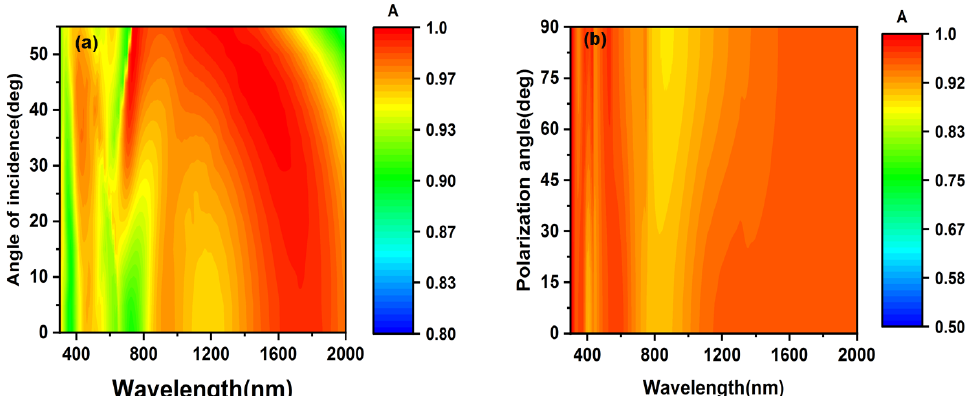
Figure 11. ( a ) The evolution of absorbers’ absorption as the incident angles increases from 0° to 55°. ( b ) The evolution of absorbers’ absorption as the polarization angles increases from 0° to